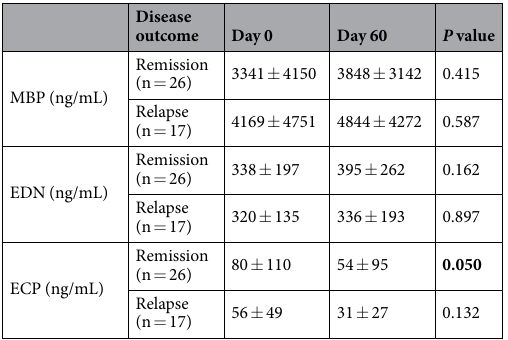
Table 2. Variations of MBP, ECP and EDN serum concentrations in patients with BP according to their clinical outcome. ECP serum concentrations were significantly decreasing between baseline and day 60 in patients with BP who achieved clinical